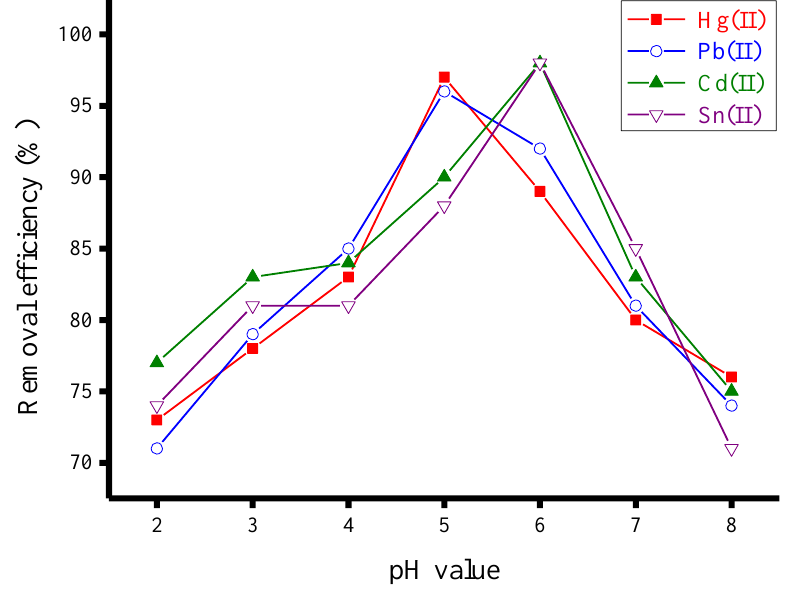
Figure 10. Removal efficiency (%) of heavy metal ions (20 mg/100 mL) using 50 mg of the synthesized ZnFe 2 O 4 -CNT adsorbent material at different pH values.